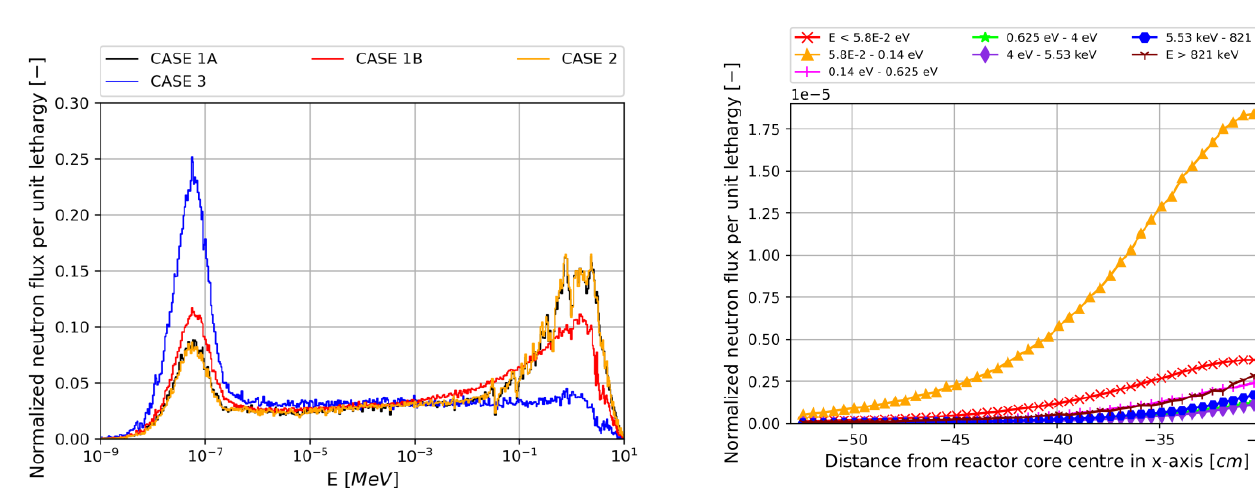
Fig. 2. Neutron spectra in the core center in all